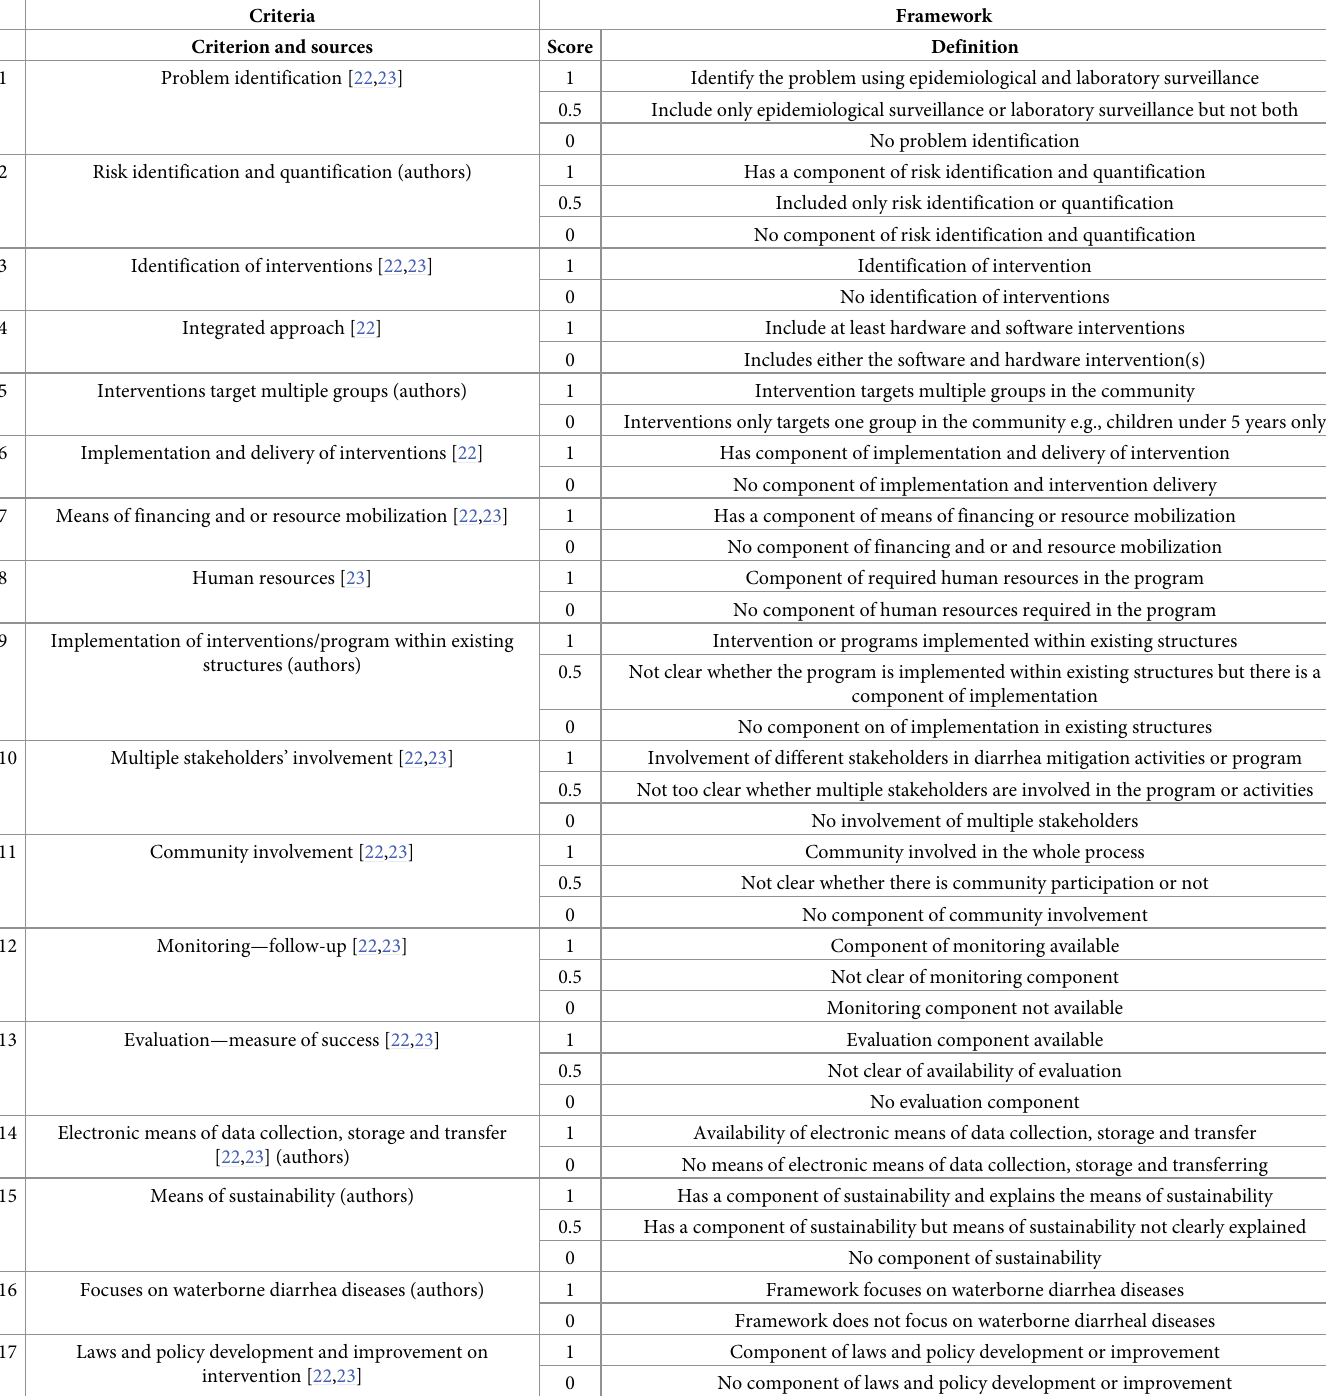
Table 1. Score sheet used to assess the strengths and weaknesses of existing frameworks for mitigating the risk of diarrheal